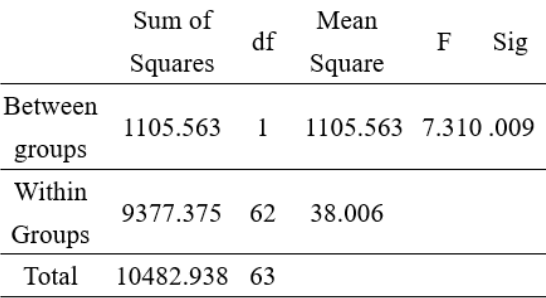
Table 6. One-way ANOVA test result